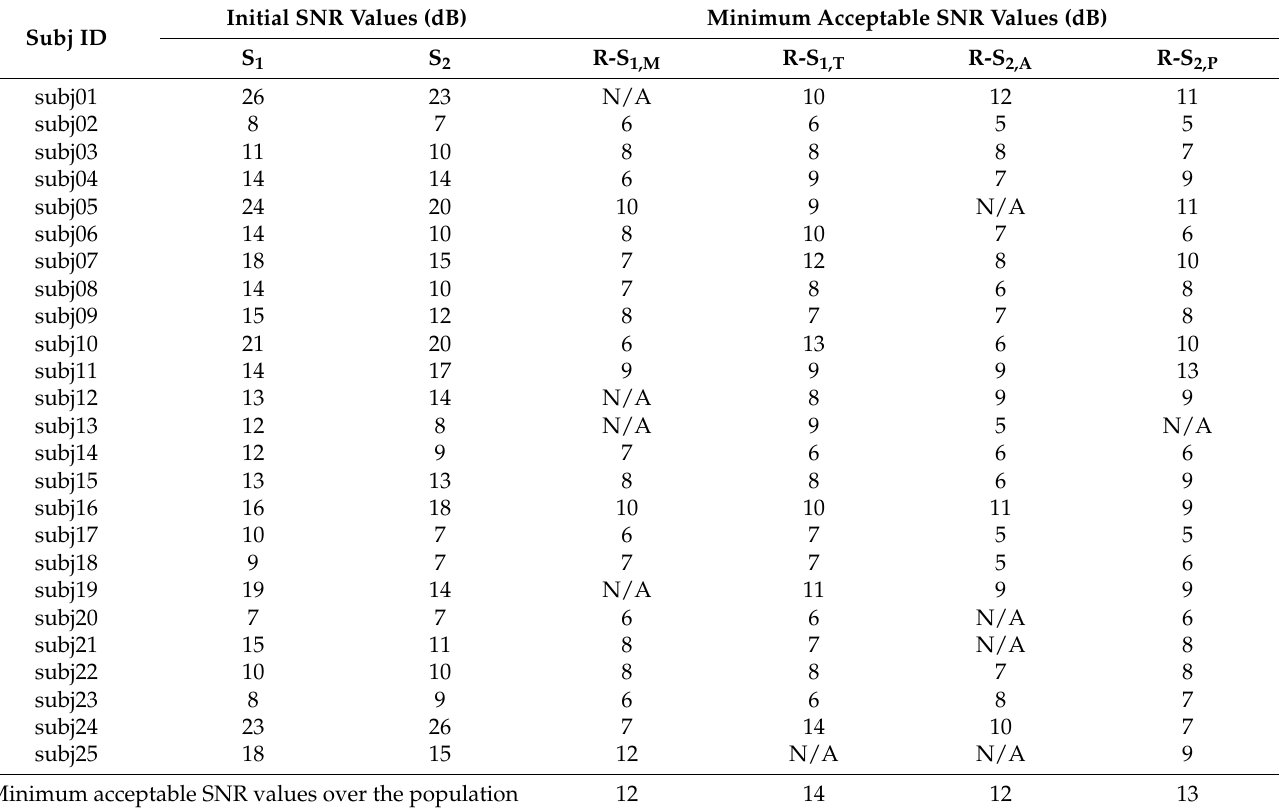
Table 1. Minimum acceptable SNR values (1-ms uncertainty). For each subject of the sample population, this table presents the initial SNR value and minimum acceptable SNR threshold for each latency. The overall SNR threshold is the maximum value obtained for each parameter. A “N/A” value (not available) is associated with signals where no threshold could be computed for a parameter because the condition was never